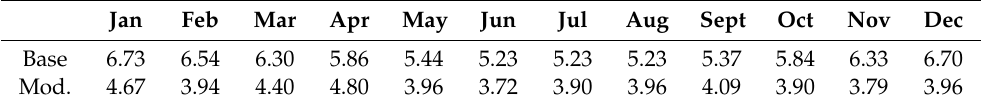
Table 4. Emission of NOx (10 3 kt) for Europe before and after modification.